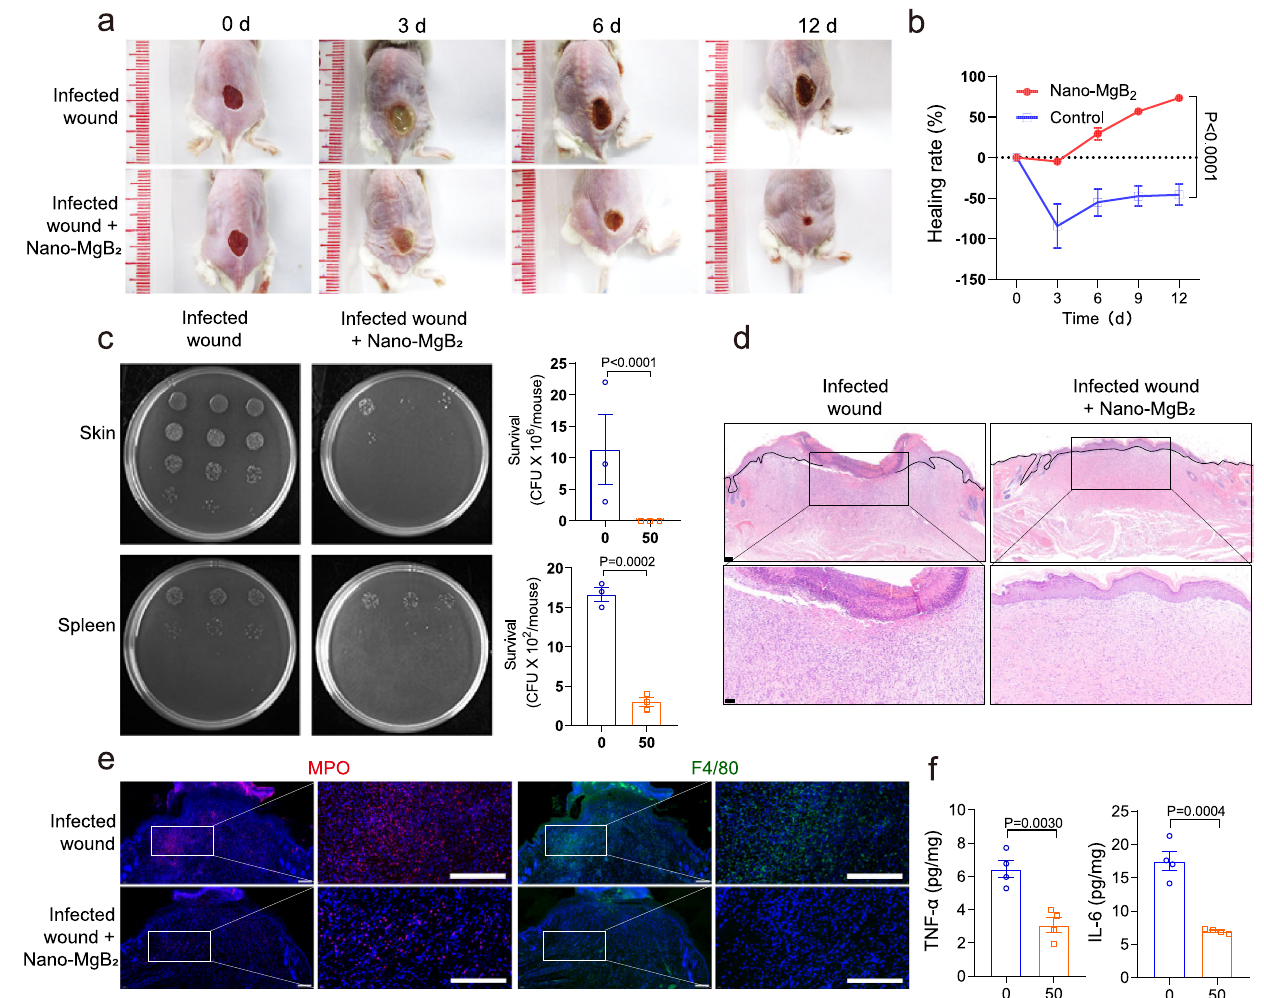
Fig. 8 | Nano-MgB 2 enhanced infected-wound healing. a Photographs of P. aer- uginosa -infectedmouseskin wounds treated with orwithout 50 μ g Nano-MgB 2 for differentdays. b The wound healing rate ofmicetreatedasin( a )( n =5biologically independent mice). c Survival of bacteria from P. aeruginosa -infected mouse skin wound or spleen taken as in ( a ) ( n =3 biologically independent mice). d H&E stainingofinfectedwoundstreatedwithorwithoutNano-MgB 2 atday12.Scalebar (up)=100 μ m, scale bar (down)=50 μ m. e Immuno fl uorescence staining with the neutrophilcellmarkermyeloperoxidase(MPO)andmacrophagecellmarkerF4/80